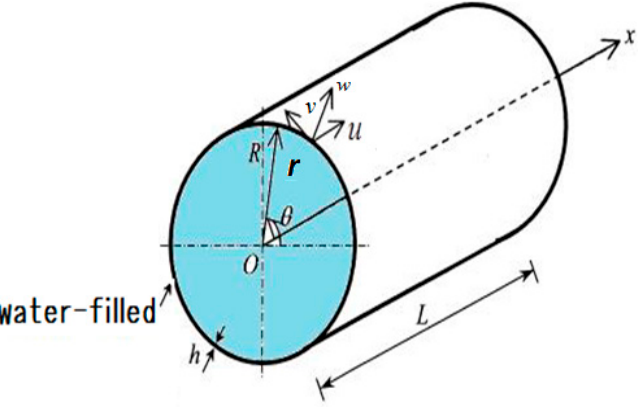
Figure 1. Tube geometry and coordinate system used.